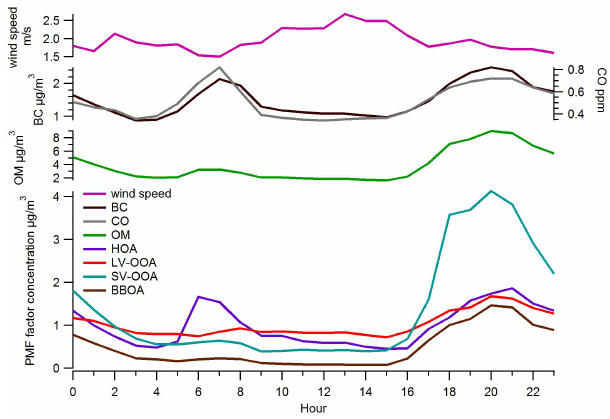
Fig. 7. PMF factor contributions, OM, BC, CO, and wind speed averaged by